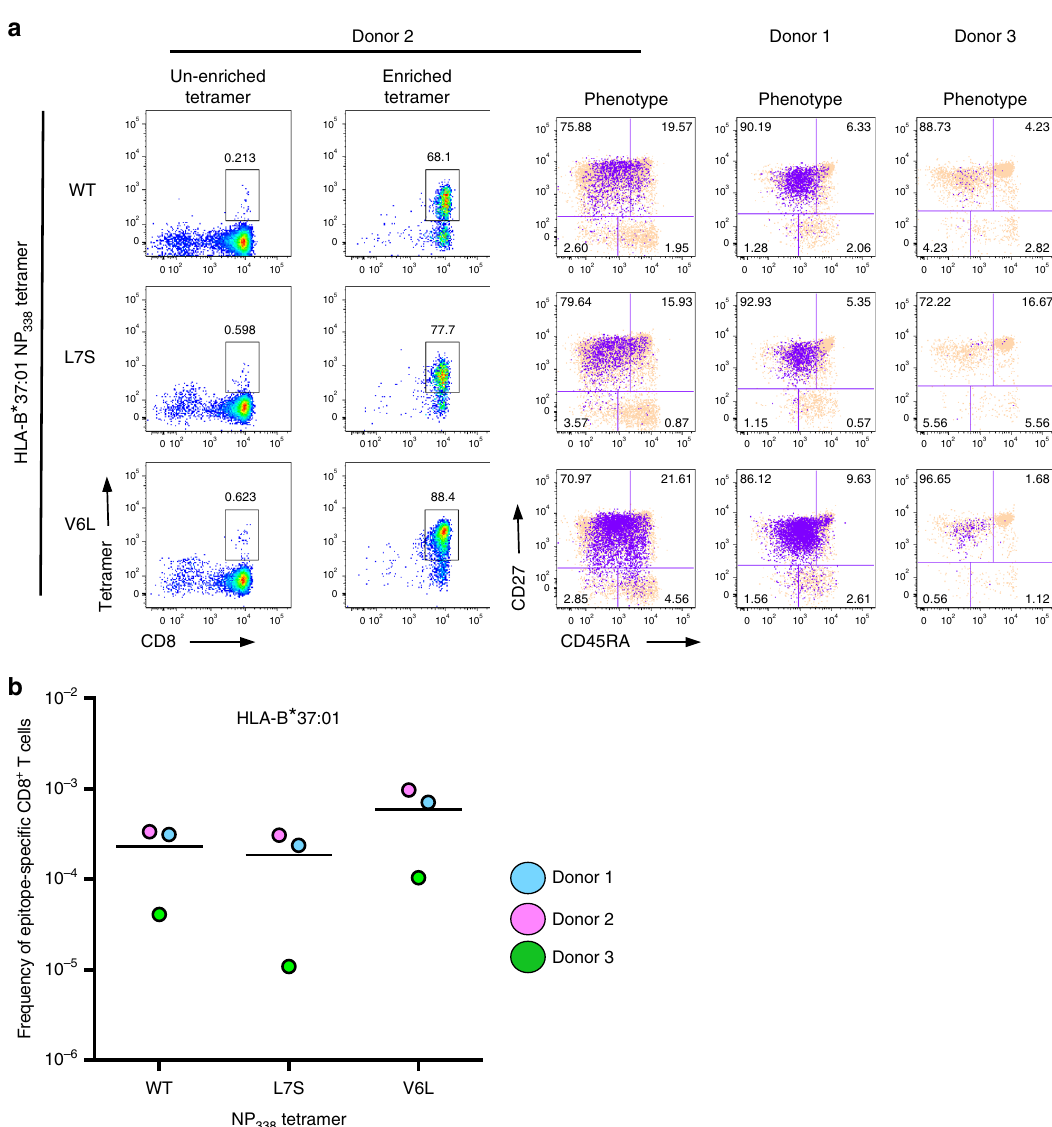
Fig. 4 HLA-B37 + NP 338 -speci fi c CD8 + T cells recognize NP 338 variants directly ex vivo. PBMCs from HLA-B*37:01 + donors ( n = 3) were tetramer stained individually with each variant NP 338 tetramer conjugated to PE and assessed via fl ow cytometry. Samples were gated on lymphocytes, singlets, CD3 + live + dump − cells; as per Supplementary Figure 2c. a Representative dot plots of tetramer staining of CD3 + cells prior to and following enrichment (numbers respond to a proportion of tetramer + of CD8 + T cells) and CD27/CD45RA phenotype of tetramer + CD8 + T cells (purple) superimposed on unenriched CD8 + T cells. b Frequency of NP 338 variant-speci fi c CD8 + T cells in HLA-B*37:01 +